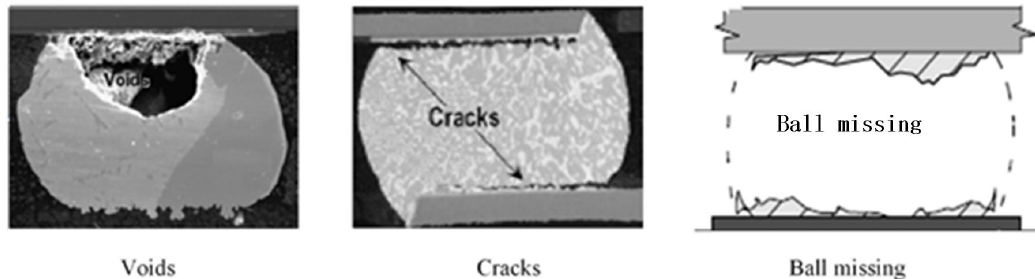
Figure 1. Solder joint defect types.